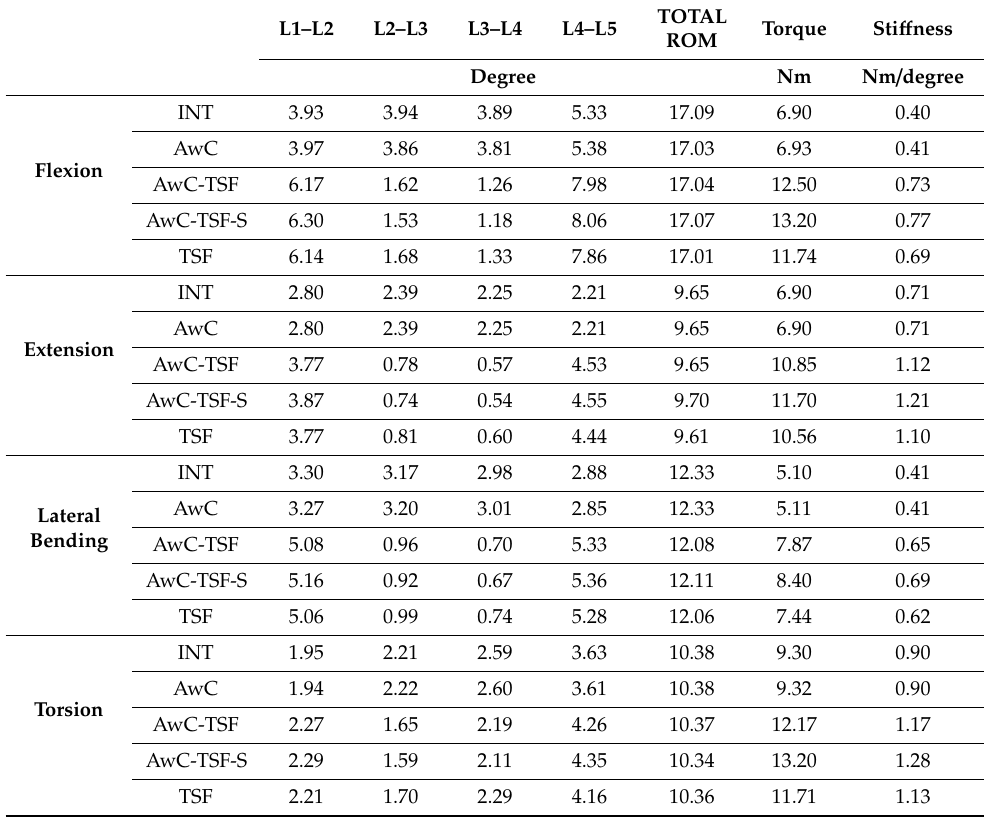
Table 2. Range of motion (ROM) of all motion segments in five finite element (FE)